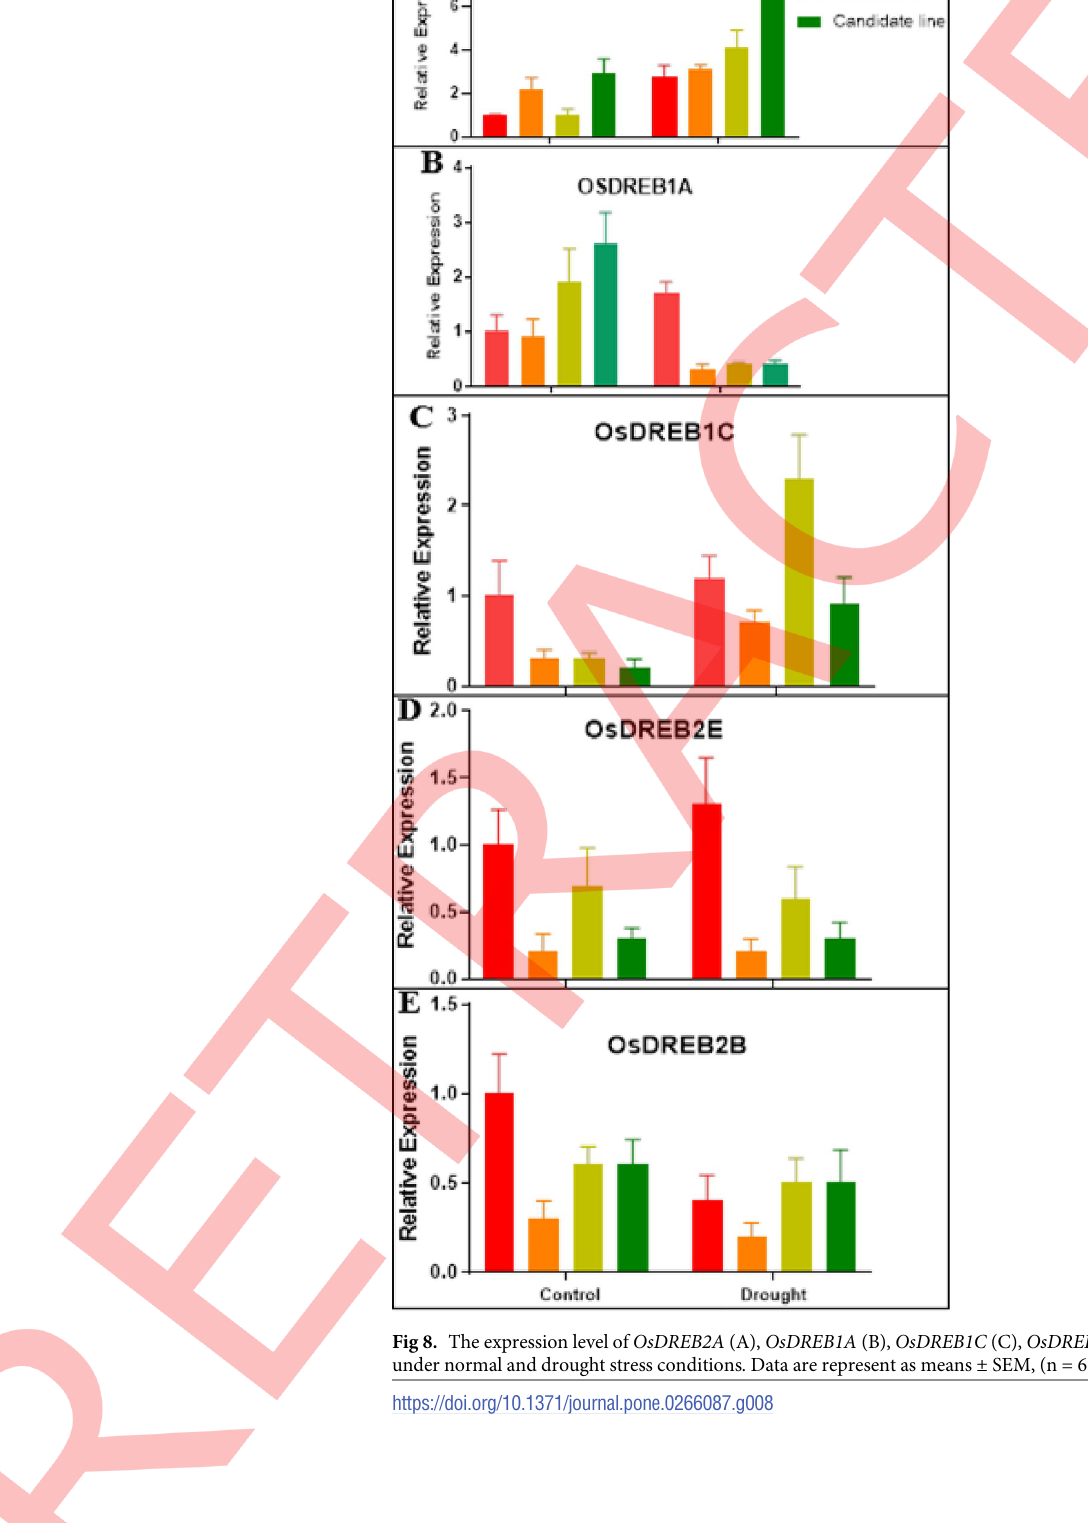
PLOS ONE | https://doi.org/10.1371/journal.pone.0266087 March 29,